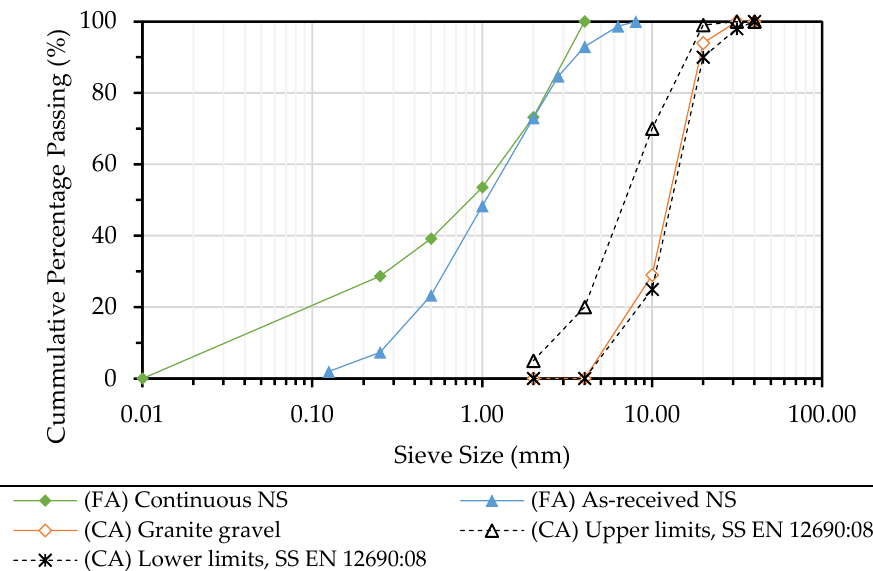
Figure 2. Gradation curves of continuous RS, as-received RS, and granite gravel.